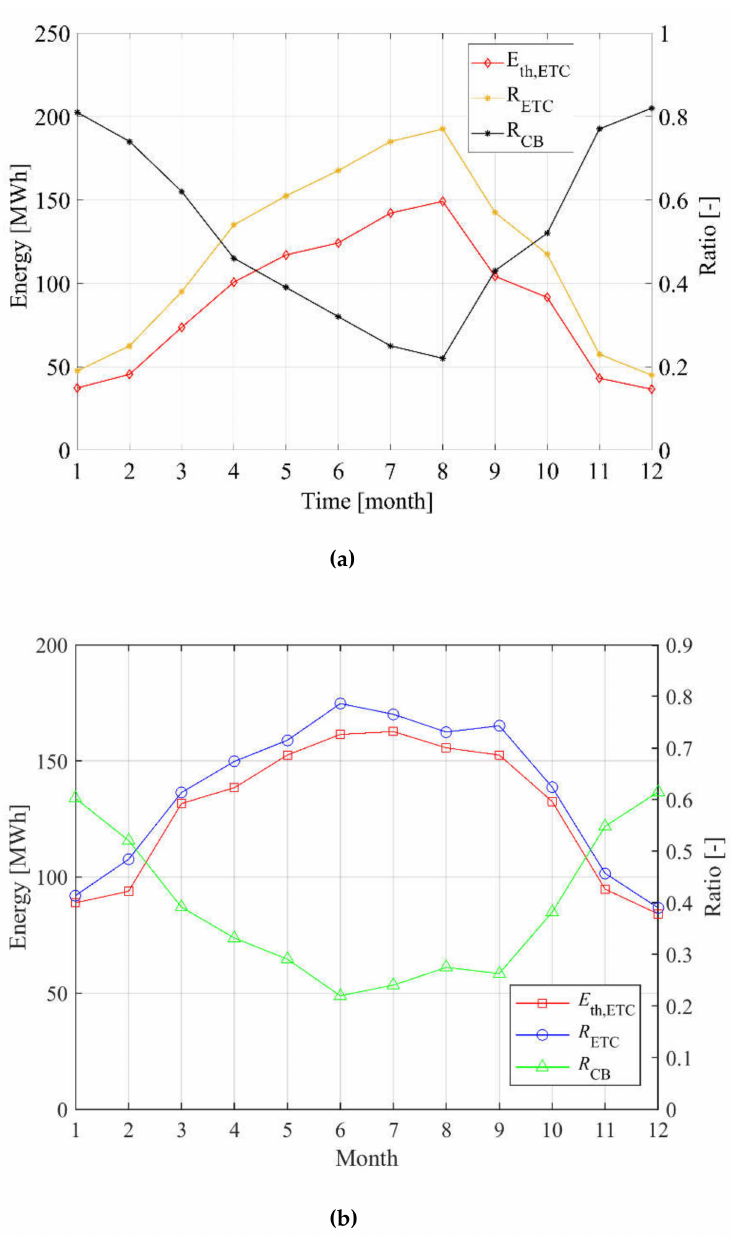
Figure 10. Monthly results: energy performance of the ETC of the PS3 for the scenario of ( a ) Naples and ( b )